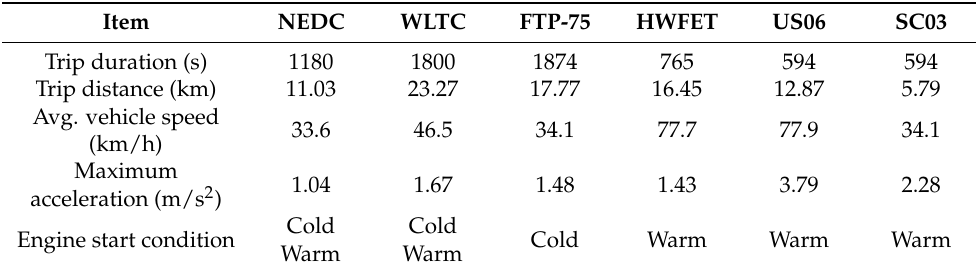
Table 3. Summaries of test modes in laboratory.